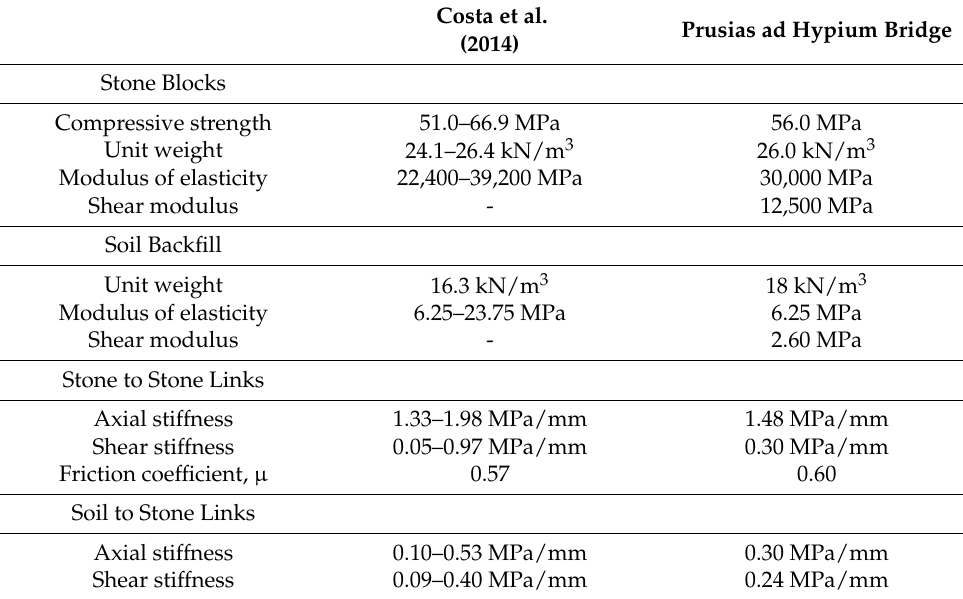
Table 2. Summary of material and interface properties.